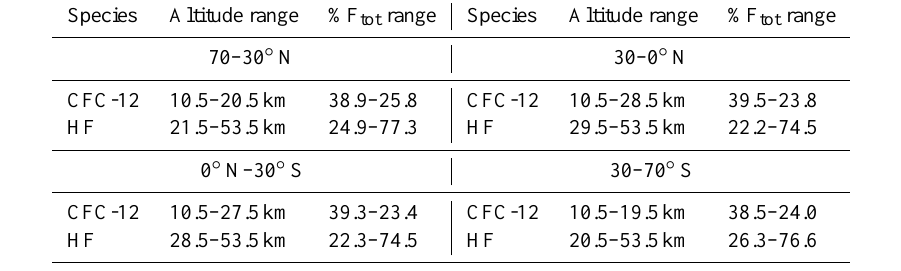
Table 6. The species which contribute the largest VMR to the total fluorine budget (F tot ) for different altitudes and latitude bands alongside its mean percentage contribution.